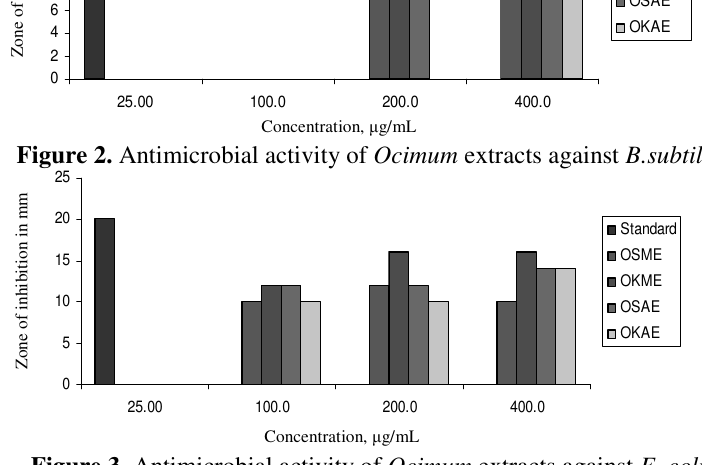
Figure 3. Antimicrobial activity of Ocimum extracts against E. coli